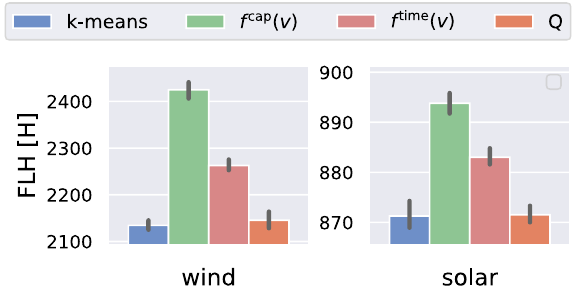
Fig. 8 Average full load hours (FLH) according to equation (10) of existing assets respective renewable technology for all model resolutions except for 37 nodes, because the FLH are equal at this